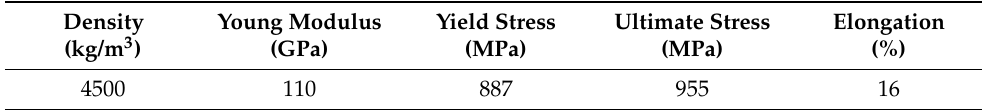
Table 3. Mechanical properties of Ti6Al4V alloy employed in this study. Density Young Modulus Yield Stress Ultimate Stress Elongation (kg/m 3 ) (GPa) (MPa) (MPa) (%) 4500 110 887 955